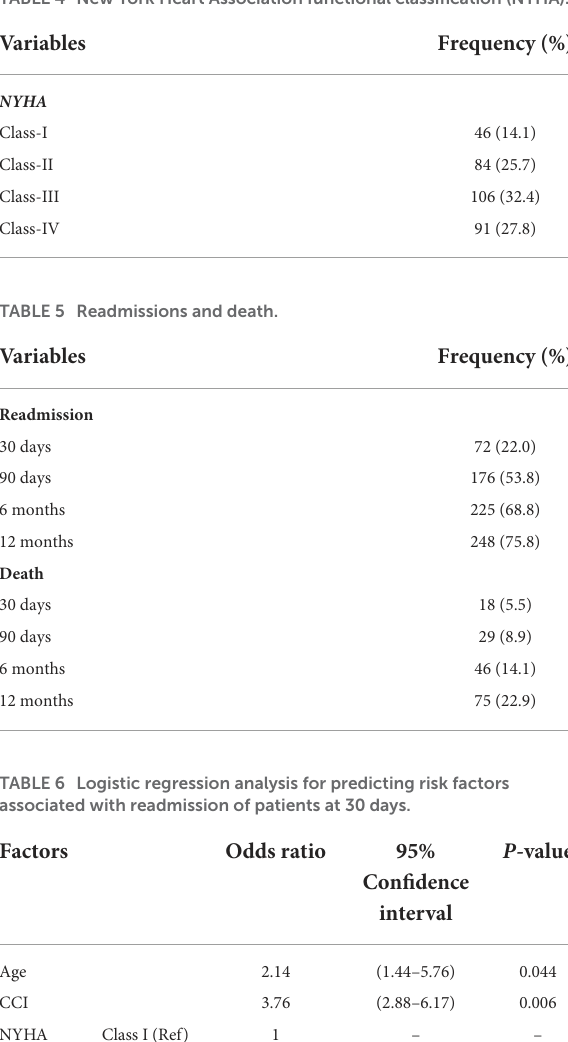
TABLE 2 Comorbidity conditions and causes of heart failure.